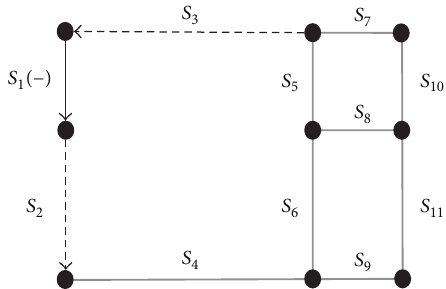
Figure 1: The data model of road network.